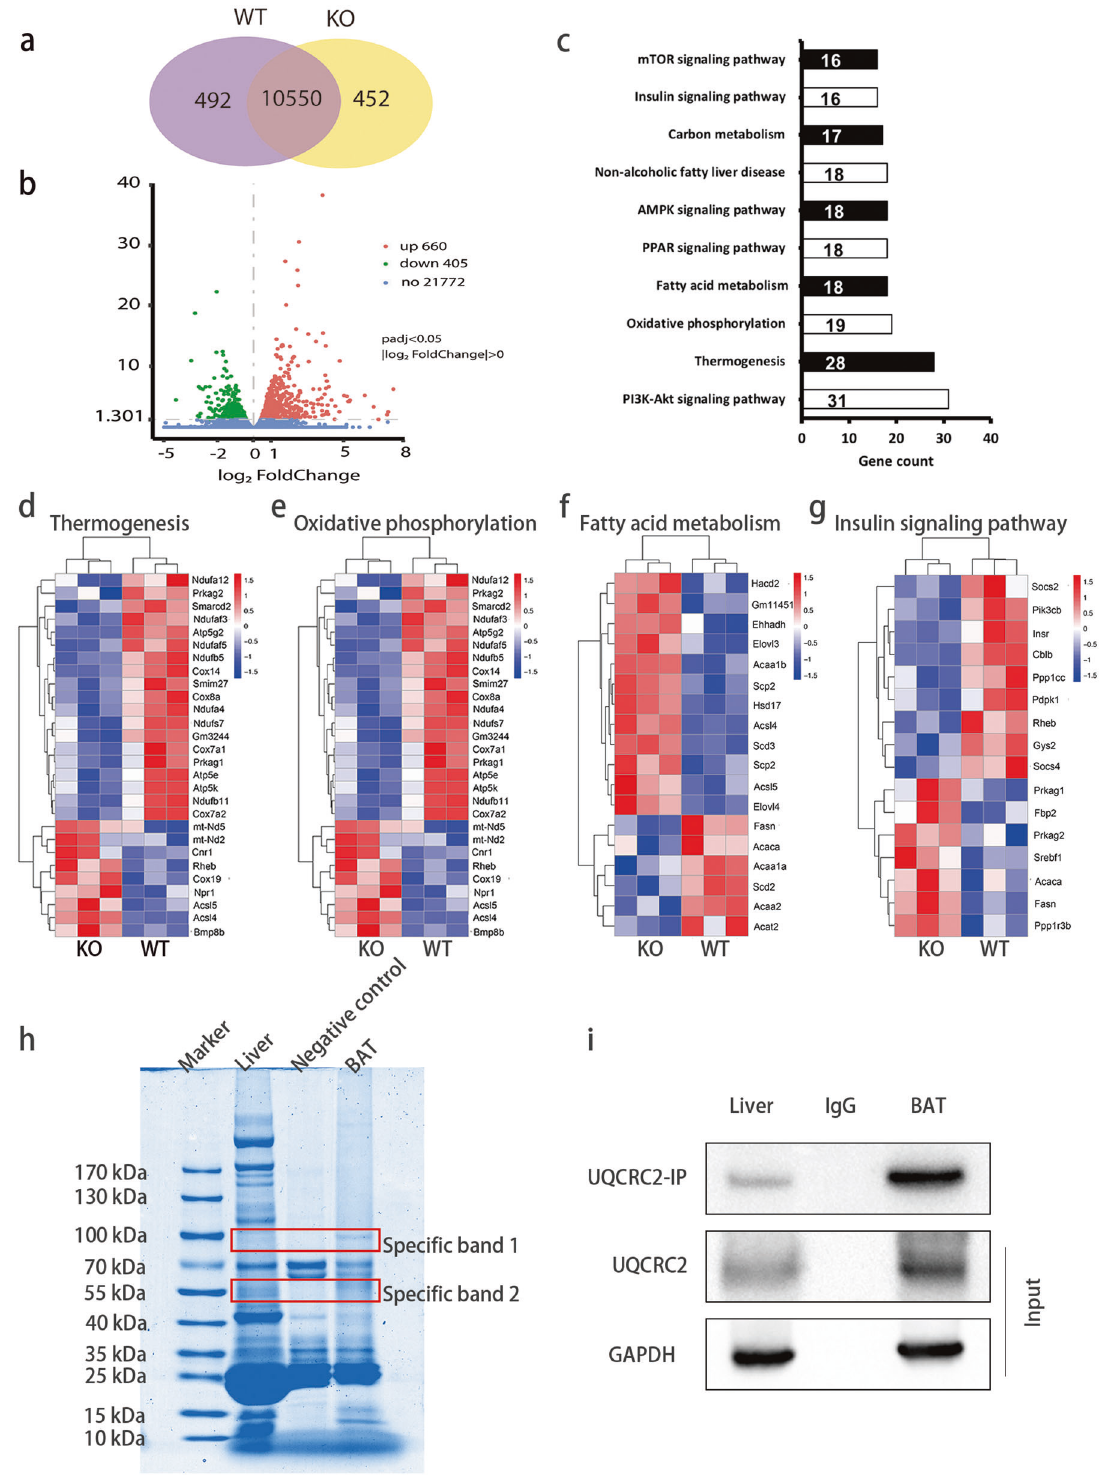
Fig. 4 Trib1 knockout leads to the decrease and dysfunction of mitochondrial assembly protein in mice. a The Venn diagram of RNA-seq indicated the number of differentially expressed genes between Trib1 -knockout and wild-type mice, respectively ( n = 3). b The volcano plot of RNA-seq showing up- and downregulated genes between Trib1 -knockout and wild-type mice. c Kyoto Encyclopedia of Genes and Genomes analysis of downregulated pathway in Trib1 -knockout mice and wild-type mice. Heat map of thermogenesis ( d ), oxidative phosphorylation ( e ), fatty acid metabolism ( f ), and insulin signaling pathway ( g ) gene clusters in Trib1 -knockout and wild-type mice. Red and blue represent upregulation and downregulation expression, respectively. h The fi nal elution (CoIP) samples were analyzed by Western blot and stained with Coomassie brilliant blue. The speci fi c bands were used for mass spectrometry analysis. i The fi nal elution (CoIP) samples were analyzed by Western blot and incubated with uqcrc2 primary antibody.